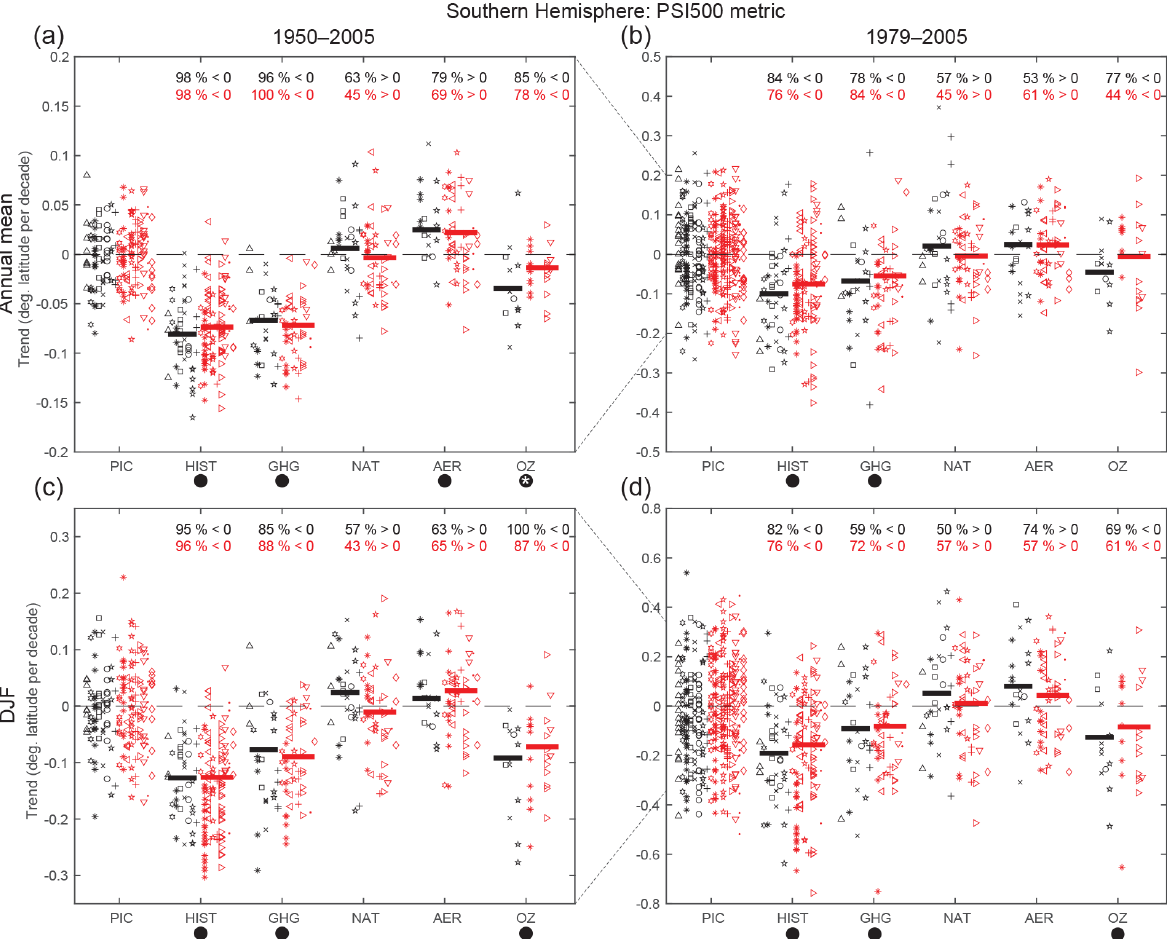
Figure 7. As in Fig. 6, but for (a, b) annual-mean SH Hadley cell edge latitude and (c, d) DJF-mean SH Hadley cell edge latitude (as measured by PSI500